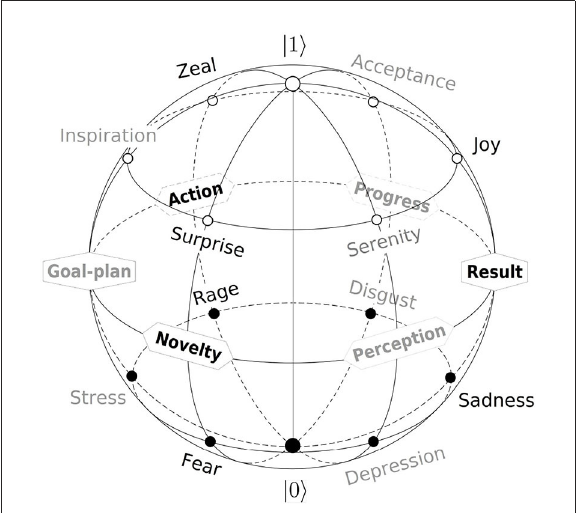
FIGURE3 The qubit model of subjective experience in the Bloch-sphere representation. Each of three primary (black) and three secondary (gray) process stages, shown in Figure 2B, generates one positive and one negative emotional prototype. Positive and negative experiences occupy the northern ( θ > 90 ◦ ) and southern ( θ < 90 ◦ ) Bloch hemispheres according to Figure 2A. Modified from Surov